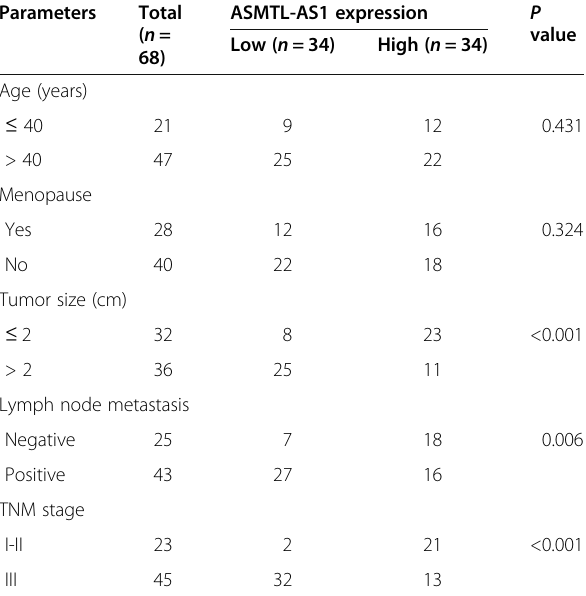
Table 1 Association of ASMTL-AS1 expression with clinical features in 68 triple-negative breast cancer patients